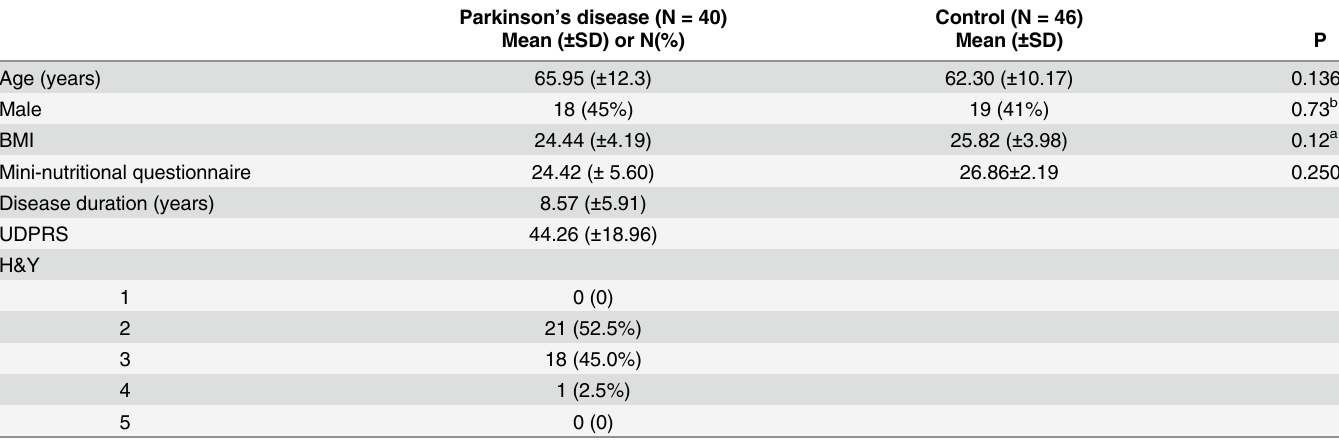
Table 1. Sociodemographic information of patients with Parkinson ’ s disease and controls.